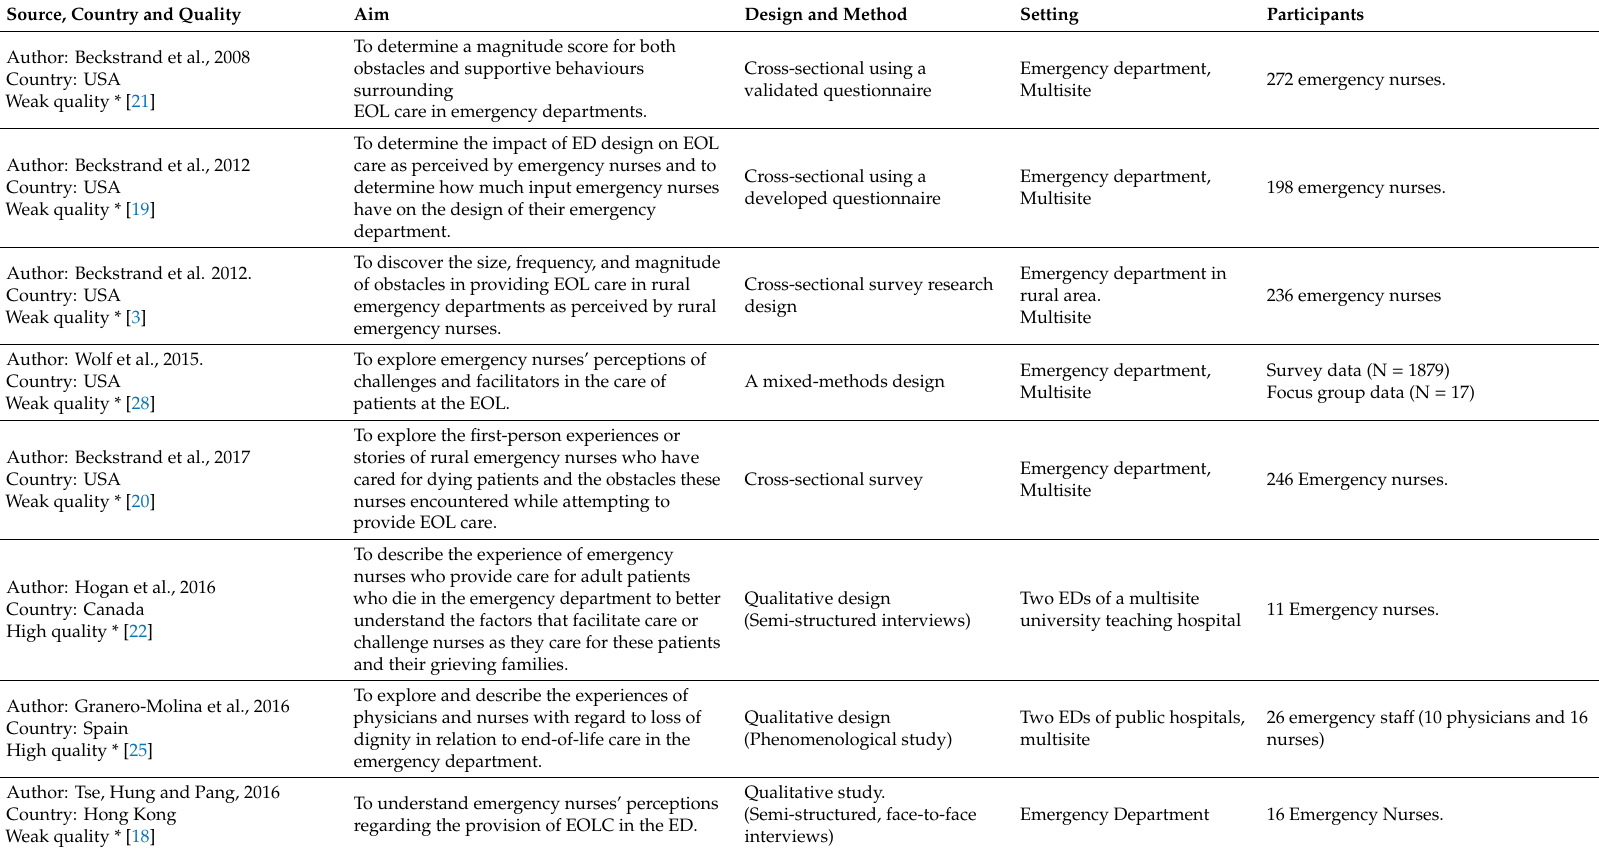
Table 1. Extraction of data from included